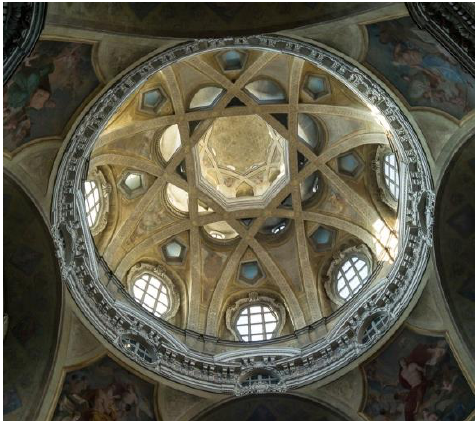
Fig. St. Francis from Paola - anamorphic view (Maignan, Trinità dei Monti Rome, 1642)